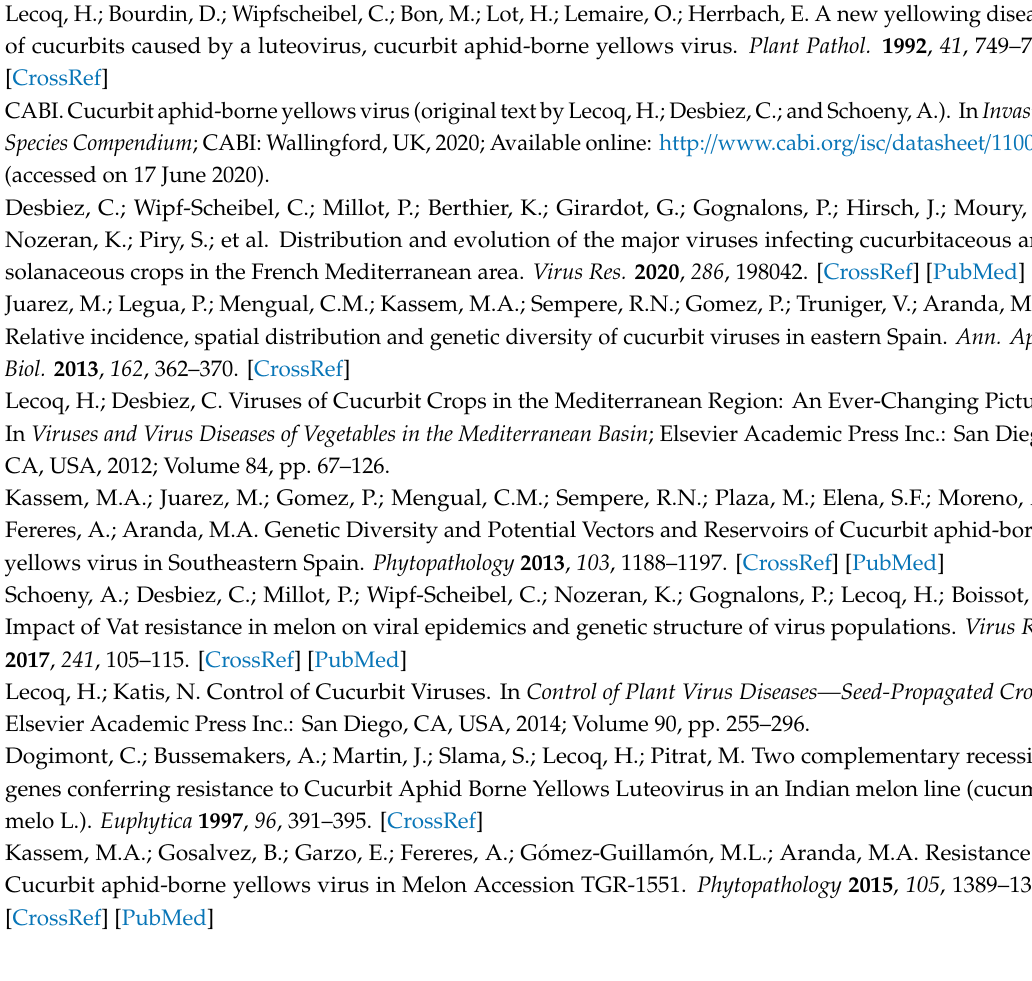
Table S2: Significant correlations (with a maximal type-1 error of 1%) between virus variables and aphid variables computed on periods relative to the date of epidemic peak ( µ ). Significant correlations involve abundances of Aphis gossypii (RIS-181) aggregated between t 1 = µ − ∆ t 1 and t 2 = µ − ∆ t 1 + ∆ t 2 (in days from planting date). The relationship between the virus variable and the aphid variable was modelled with a linear model ( z k = A 0 + A 1 . x k ) for the area under the disease progress curve (AUDPC 56 ) and an exponential model ( z k = B 0 + B 1 the parameter γ of the logistic equation. No aphid variable was found significantly correlated to µ